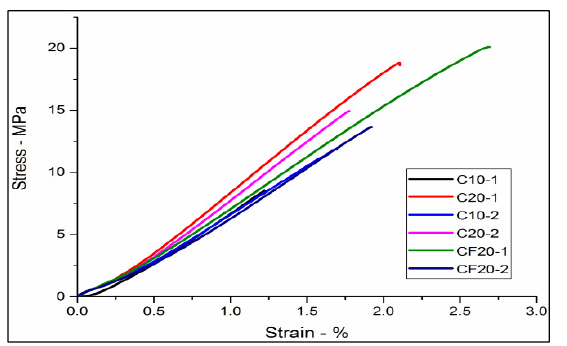
Fig. 4: Stress-strain curves for bagasse composites The effect of fiber weight percentage and fiber length on the tensile properties of bagasse-reinforced